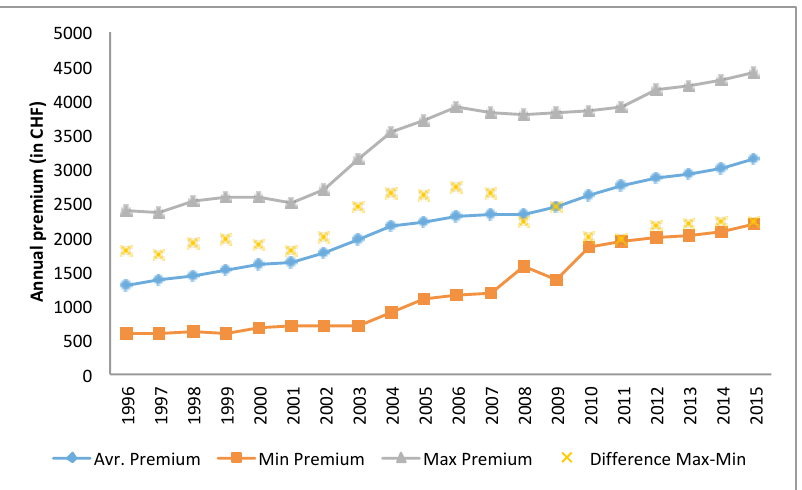
Figure 6. Premium range in Switzerland, 1998–2015.